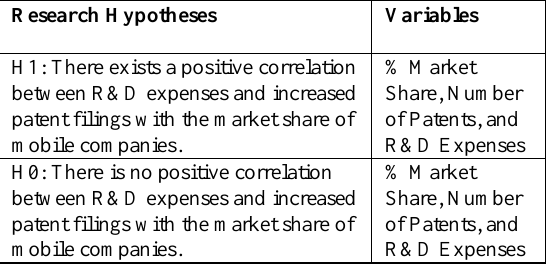
Table 2: Research Hypotheses and Variables Research